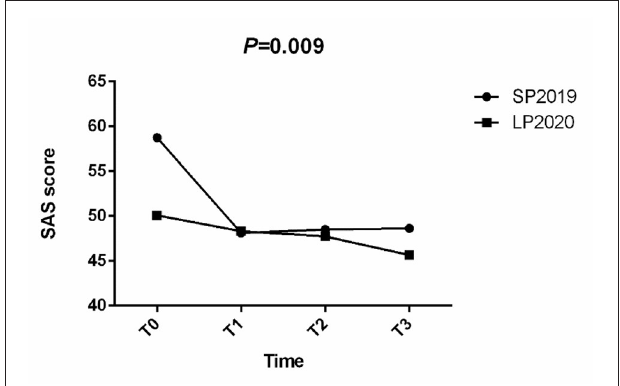
FIGURE 4 | SAS scores at T0, T1, T2, and T3, by group (SP2019, LP2020).